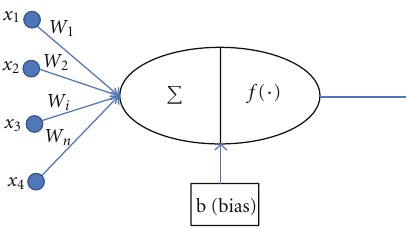
Figure 1: The diagram of one